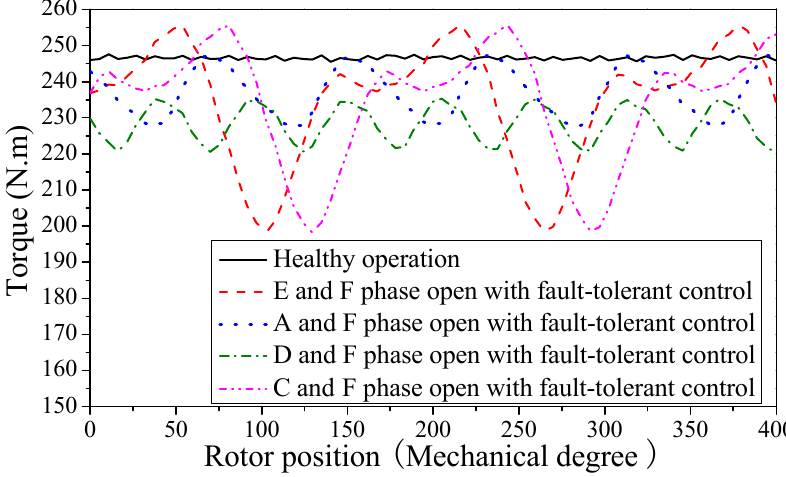
Figure 17. Torque behaviors for healthy operation and two-phase-open fault-tolerant control.